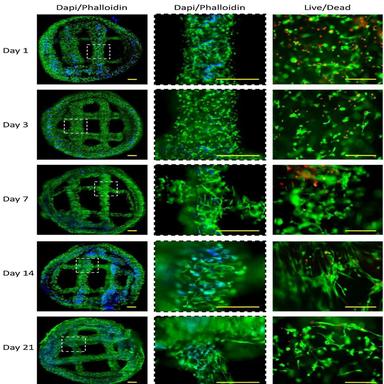
Microscope images of ZS-EI-ELR bioink scaffolds loaded with HFF-1. Dapi/Phalloidin staining of a complete printed structure and a magnified zone into the middle, and L/D assays over a 21-day culture. Scale bar for dapi/phalloidin: 500 m; for live/dead: 200 m.